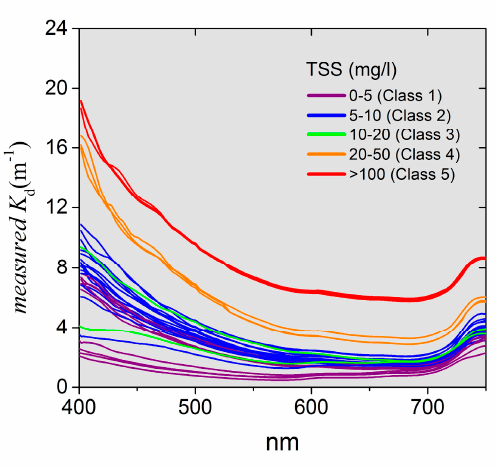
Figure 6. Diffuse attenuation coefficient K d ( λ ), for both field campaigns for classes under different mining impacts from low impact ( Class 1 ) to very high ( Class 5 ). Table 4. Correlation coefficients between suspended sediment, chl-a , and a cdom , with measured and modeled AOPs. Data are from high and low water ( n = 40). * indicates significant correlation at p < 0.05. Measured AOPS